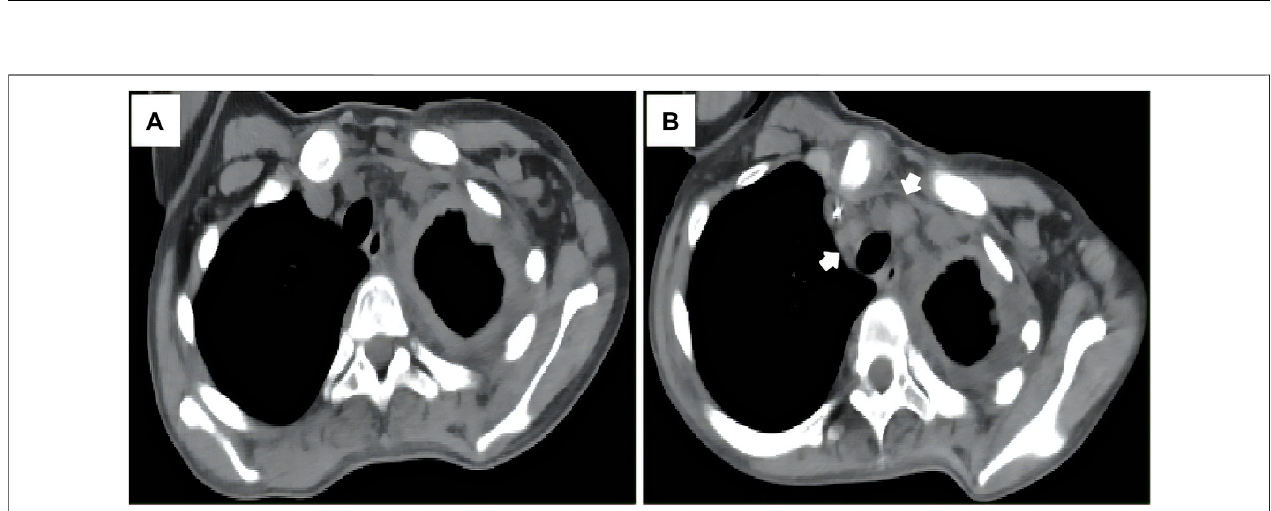
FIGURE4| Thepatientexperiencedprogressivediseaseduringtherapy,asindicatedbytheprogressionofthemediastinallymphnodemetastases[ (A,B) ,arrow].